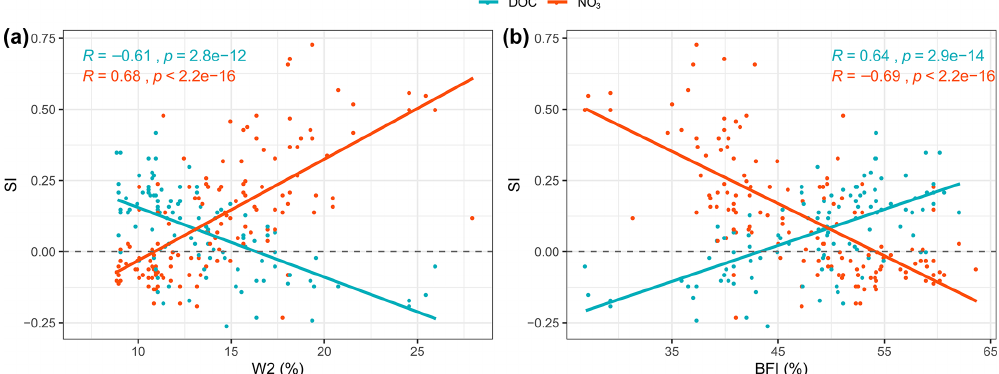
Figure 7. Relationship between the seasonality index (SI) of dissolved organic carbon (DOC) and nitrate (NO 3 ) and the hydrological reactivity descriptors (a) flow flashiness index ( W 2) and (b) base-flow index (BFI) for 124 headwater